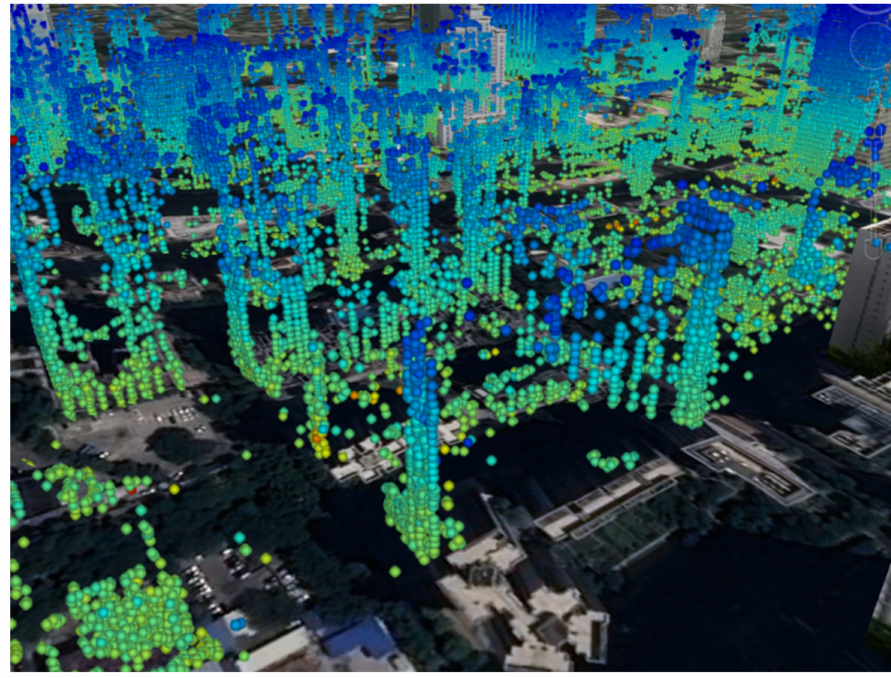
Figure 3. Estimated PS points with the residual height color-coded in Guangzhou.